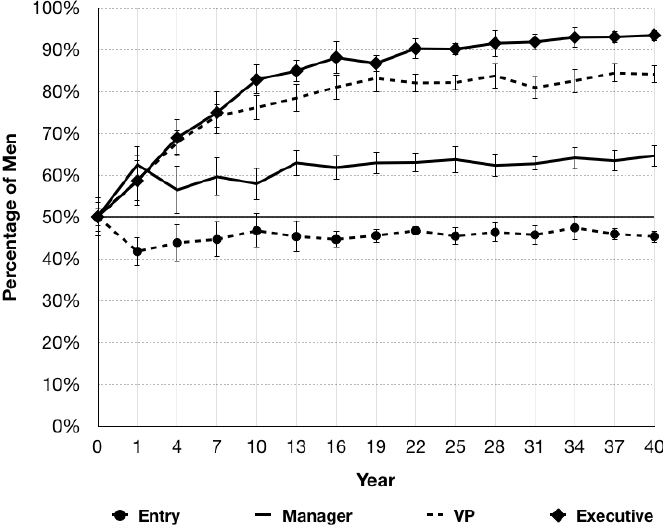
Figure 4. Fluctuations in gender balance across all four levels during a 40-year simulation when the promotion bias is 0.3.